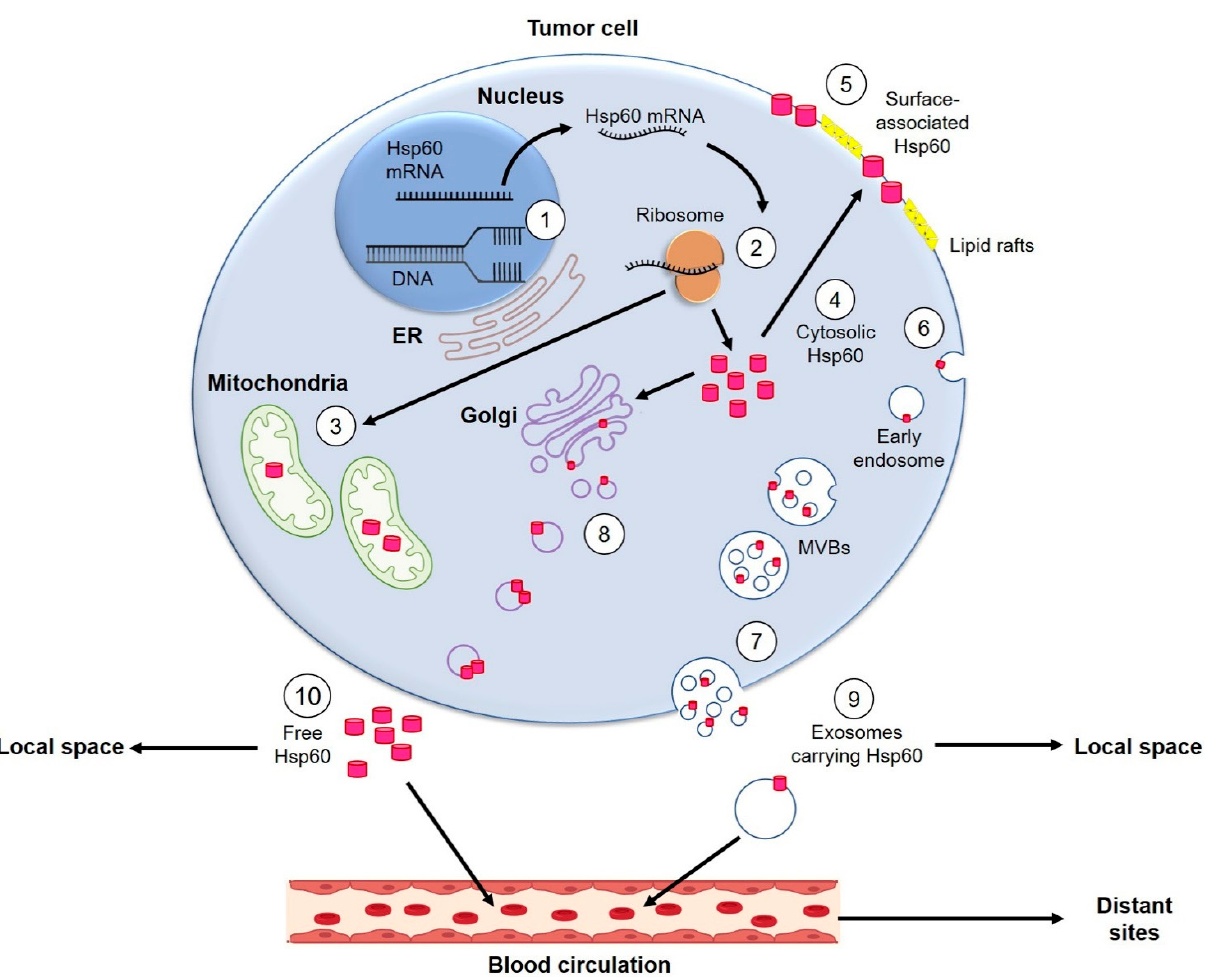
Figure 2. Diagram representing the Hsp60 secreting mechanism. Hsp60 (pink cylinder) is encoded in a single nuclear gene (1). After translation (2), Hsp60 is translocated to the mitochondrion matrix, in which it performs its canonical chaperoning function (3). In tumor cells, Hsp60 accumulates in the cytosol (4), and/or reaches the plasma-cell membrane, near lipid rafts (yellow) (5). The membrane-associated Hsp60 is internalized through a mechanism of endocytosis into early endosomes (6), and then secreted via exosomes after the fusion of multivesicular bodies (MVBs) with the plasma-cell membrane (7). Hsp60 is also exported extracellularly via the classic Golgi-mediated secretion pathway (8). Exosomal Hsp60 (9) and free Hsp60 (10) can reach other cells, e.g., tumor cells and immune cells, nearby or in distant sites via